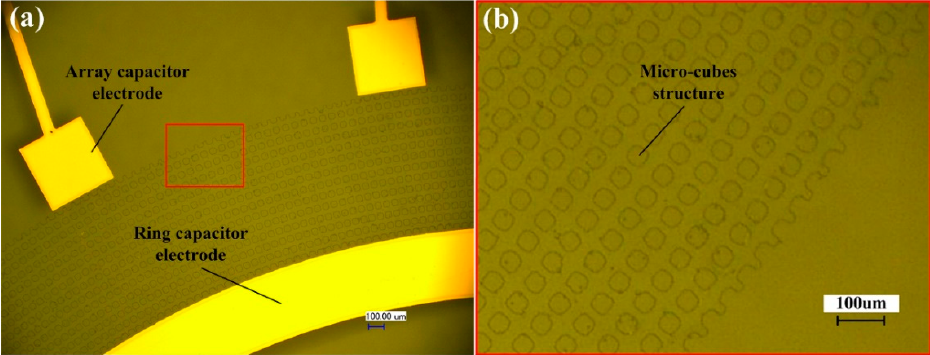
Figure 10. ( a ) Schematic diagram of micro-cube structure in sensors. ( b ) Detail of the micro-cube structure in the red square.